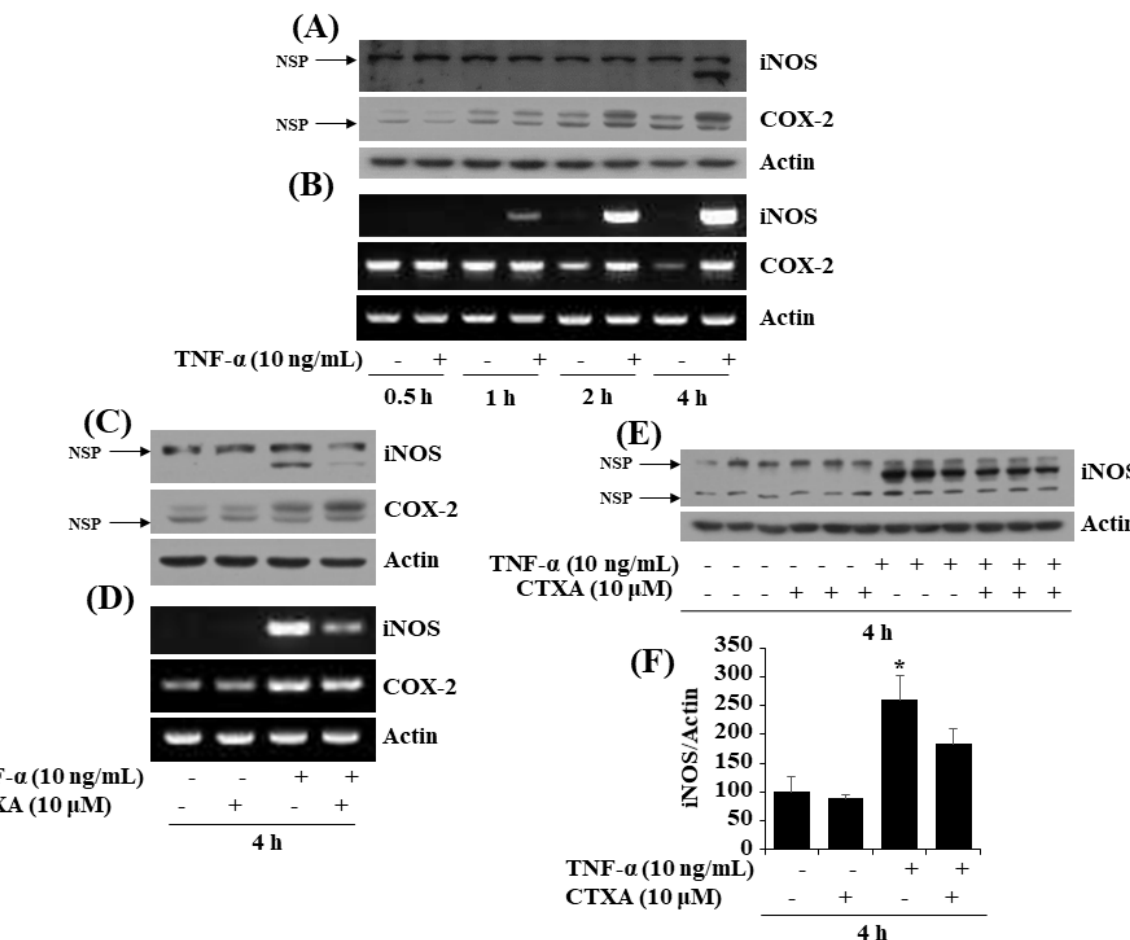
Figure 6. Effects of CTXA on tumor necrosis factor (TNF)- α -induced expression level of inducible nitric oxide synthase (iNOS) and cyclooxygenase-2 (COX-2) in 3T3-L1 preadipocytes. ( A , B ) 3T3-L1 preadipocytes were treated with or without TNF- α (10 ng/mL) for designated periods. At each time point, whole cell lysate or total RNA was isolated and analyzed for iNOS and COX-2 by Western blotting or RT-PCR. ( C , D ) 3T3-L1 preadipocytes were treated with or without CTXA (10 µ M) in the presence or absence of TNF- α (10 ng/mL) for 4 h. Whole cell lysate or total RNA was isolated and analyzed for iNOS and COX-2 by Western blotting or RT-PCR. ( E ) After the treatment mentioned above in ( C , D ), whole cell lysates were prepared from three independent experiments and analyzed by Western blotting with respective antibodies. ( F ) Densitometry analysis of ( E ). * p < 0.05 compared to vehicle control. NSP, non-specific